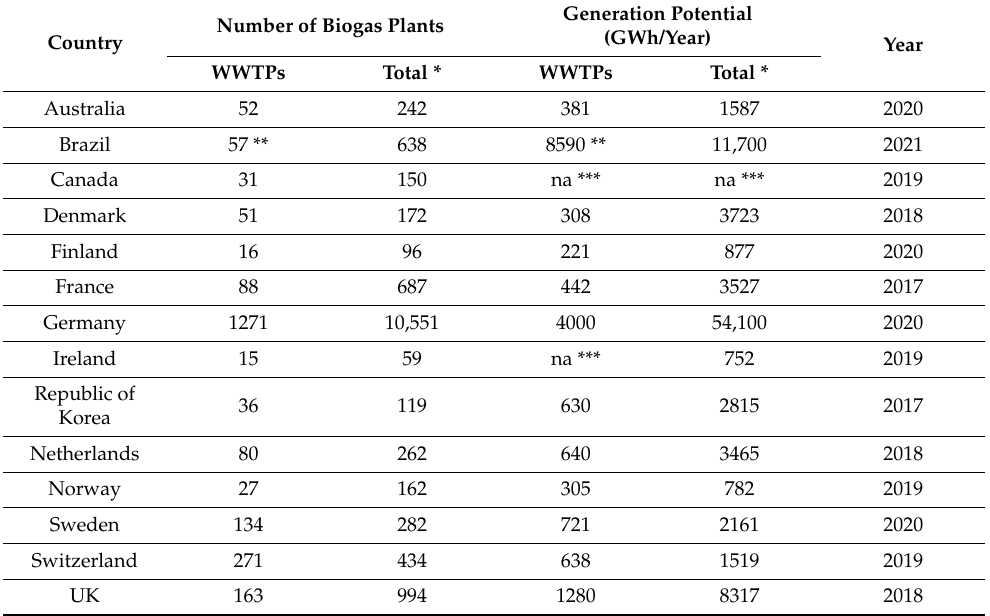
Table 5. Biogas production in WWTPs in some